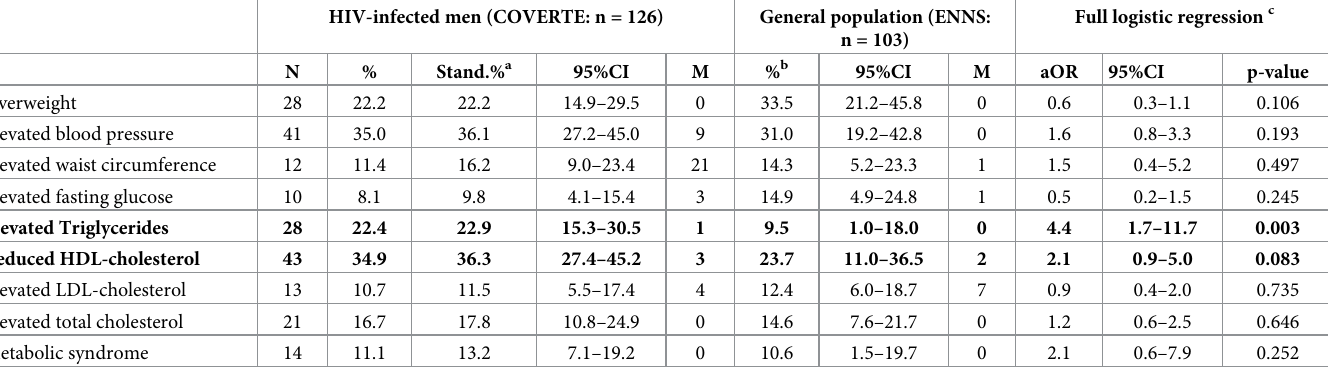
Table 4. Comparison of standardized prevalence of metabolic abnormalities in patients infected with HIV since childhood versus the general population for men (COVERTE and ENNS studies) adjusted for being overweight and education level, by logistic regression. HIV-infected men (COVERTE: n = 126)